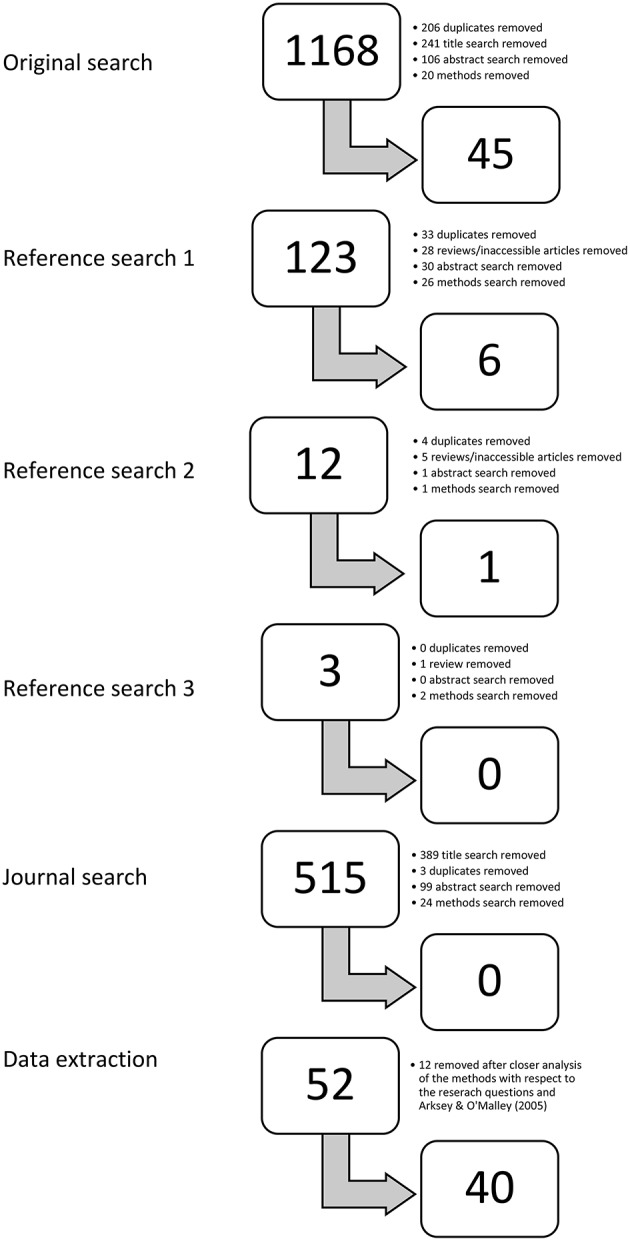
Study selection for the scoping review. Authors one and two reviewed a total of 1,699 (962+90+9+123+515) articles and found 52 suitable for the review of ASD, PA, and SF. Twelve articles were later removed because they did not fit within the inclusion criteria upon closer examination (n = 40). The methods were adapted from Arksey and O'Malley (2005).